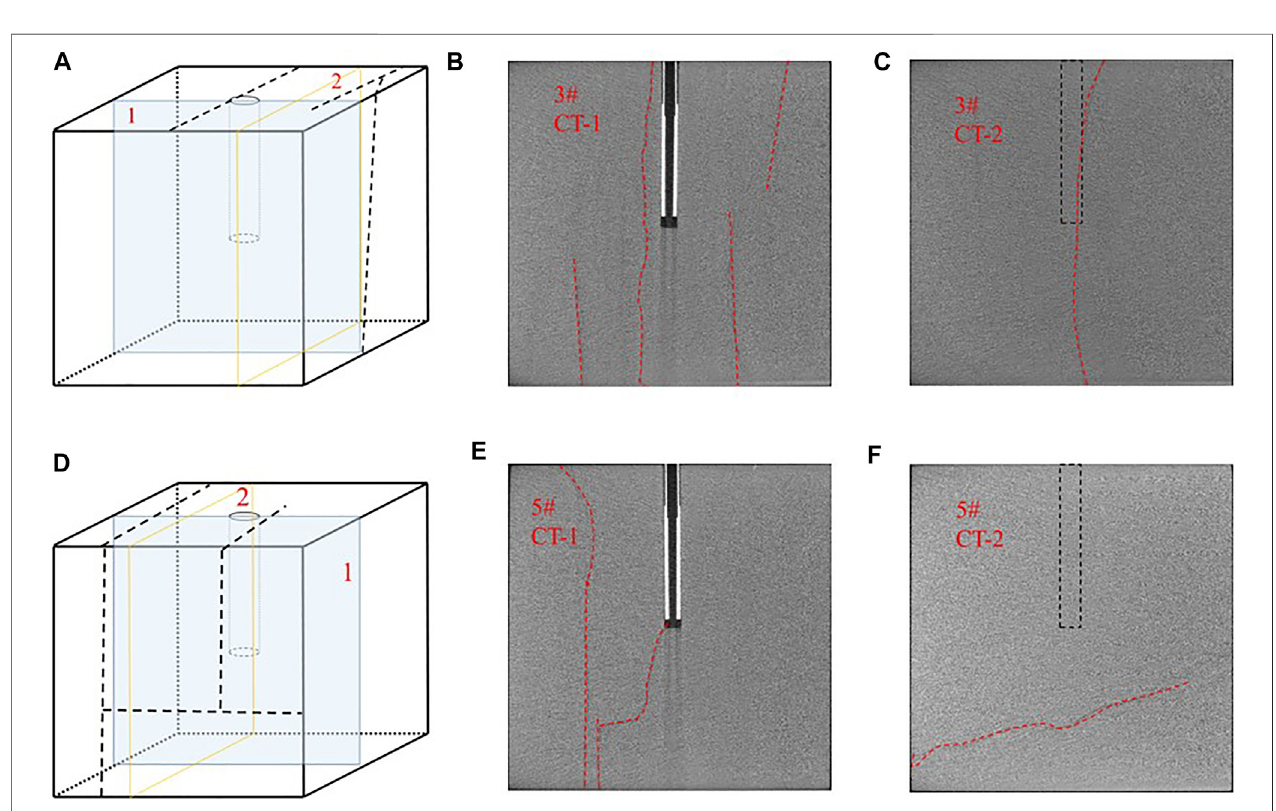
FIGURE 5 | CT scanning images of the specimens 3#: (A) Scanning position of specimen 3#; (B) Scanning section 1 of specimen 3#; (C) Scanning section 2 of specimen 3#; (D) Scanning position of specimen 5#; (E) Scanning section 1 of specimen 5#; (F) Scanning section 2 of specimen 5#.